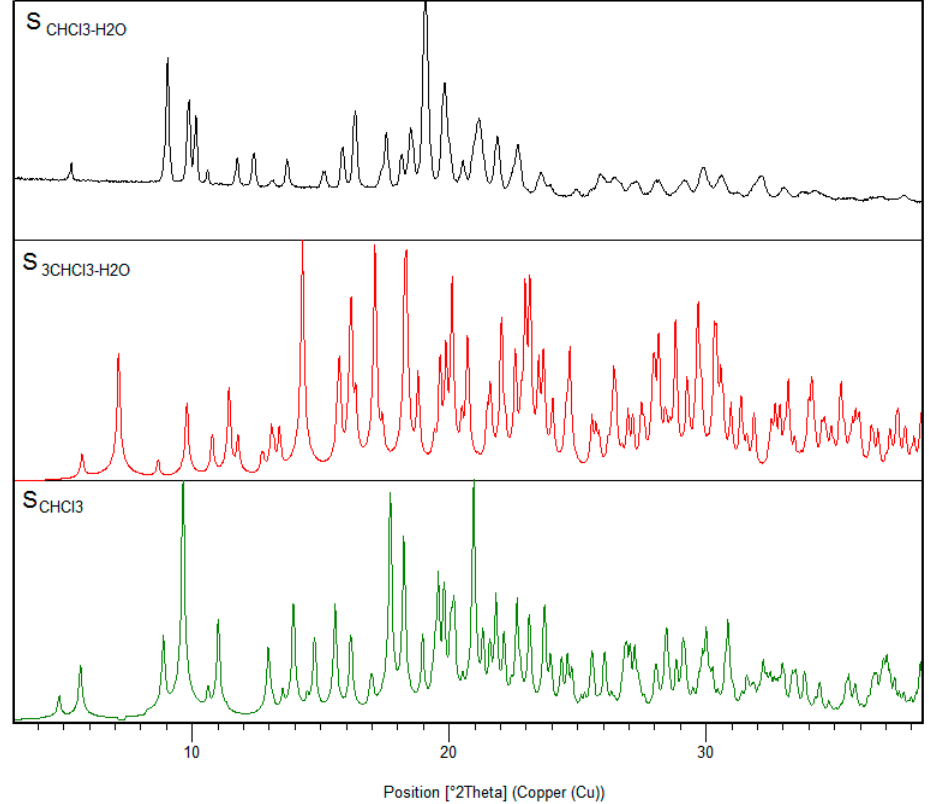
Figure 7. PXRD comparison among the different chloroform solvates.